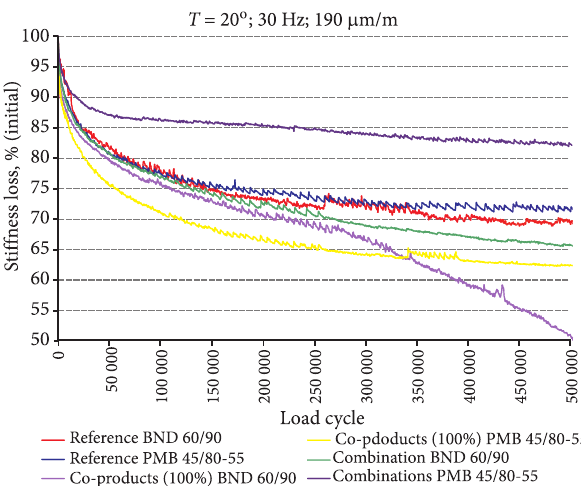
fig. 6. Fatigue test results – stiffness reduction